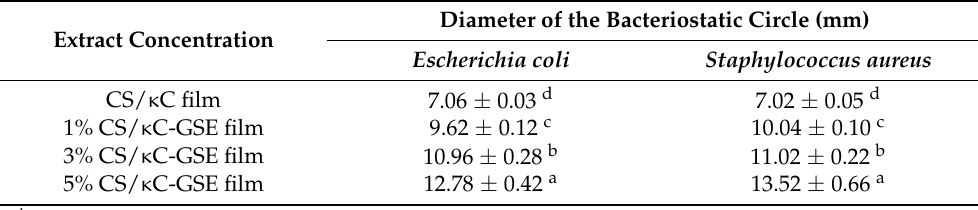
Table 3. Antibacterial activity of CS/ κ C and CS/ κ C-GSE films against E. coli and S. aureus . Extract